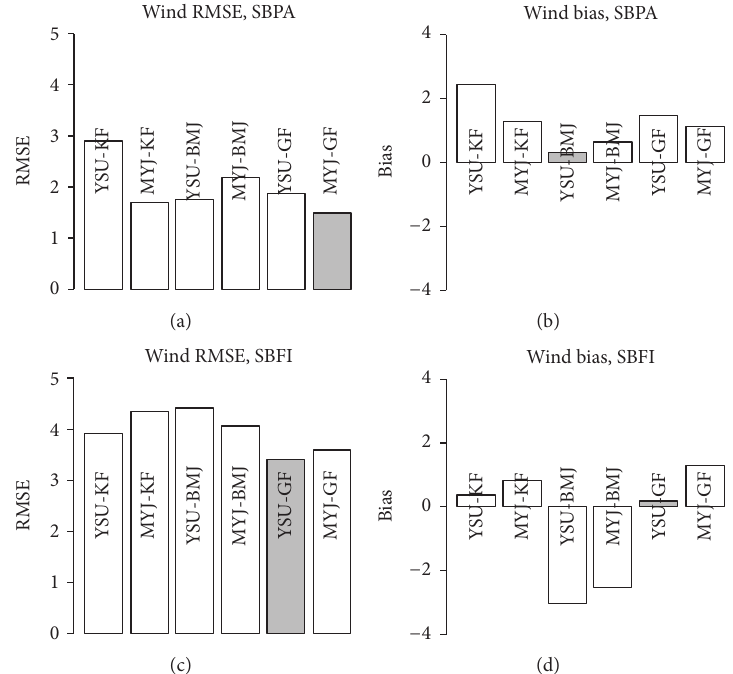
Figure 14: As in Figure 8 but for the simulated wind profiles at SBPA [(a)-(b)] and SBFI [(c)-(d)] sites evaluated at 12Z 18 January 2010.